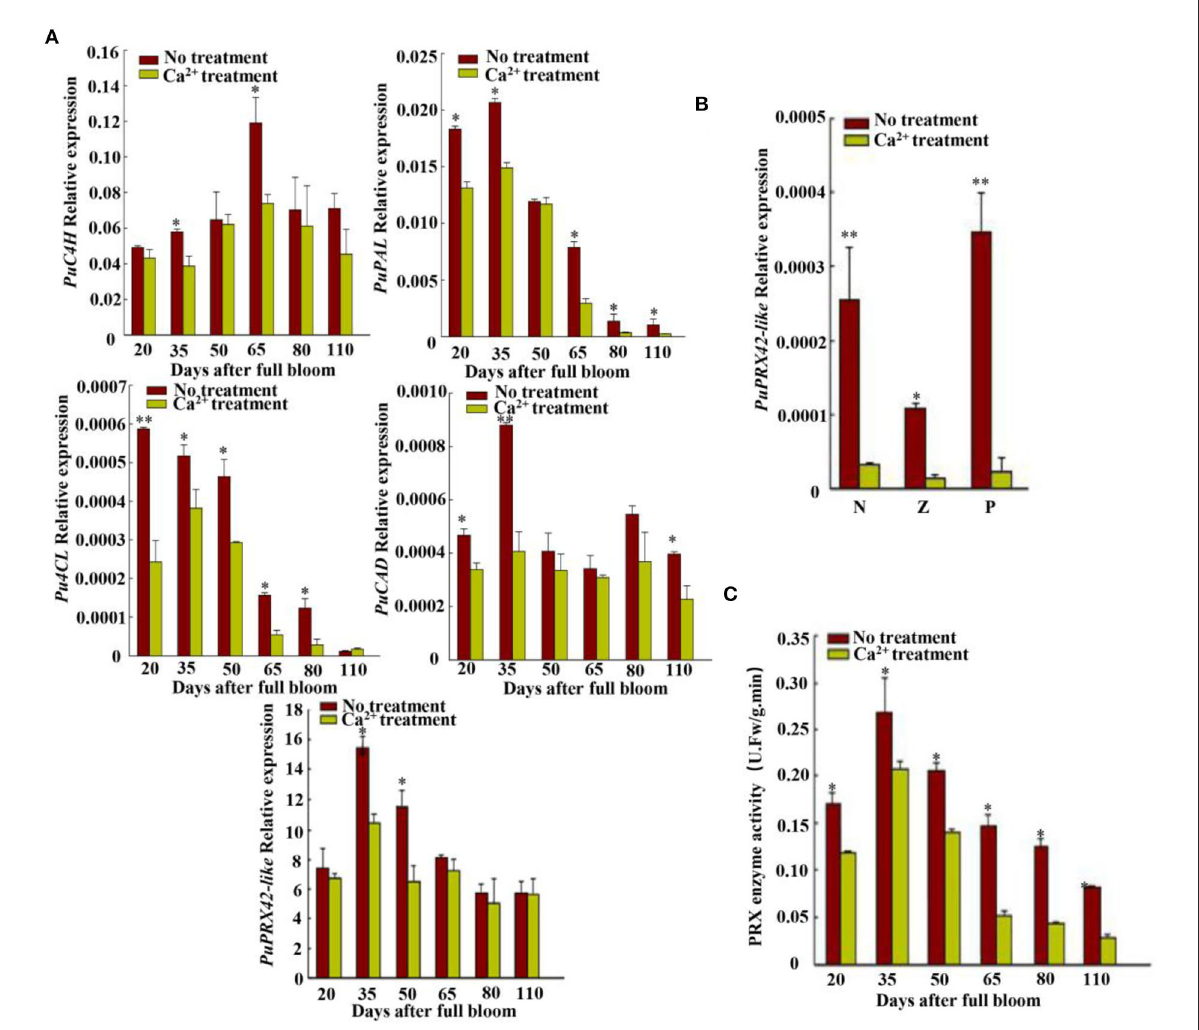
FIGURE2 Synthetic lignin relative gene expression and PRX enzyme activity analyses. (A) Expressions of lignin biosynthesis genes PuC4H , PuPAL , Pu4CL, PuCAD , and PuPRX42-like were measured at six fruit developmental stages; PuC4H , cinnamate 4-hydroxylase gene; PuPAL , phenylalanine ammonia lyase gene; Pu4CL , 4-coumarate gene; PuCAD , cinnamyl alcohol dehydrogenase gene; PuPRX 42-like, peroxidase gene. (B) PuPRX42-like expression in different pear tissues. N, flesh close to the core; Z, flesh in the middle; P, flesh close to the fruit skin. (C) PRX enzyme activity at six developmental stages. Data are shown as mean ± SE. Statistical significance was determined by Student’s t -test: * P < 0.05, ** P <